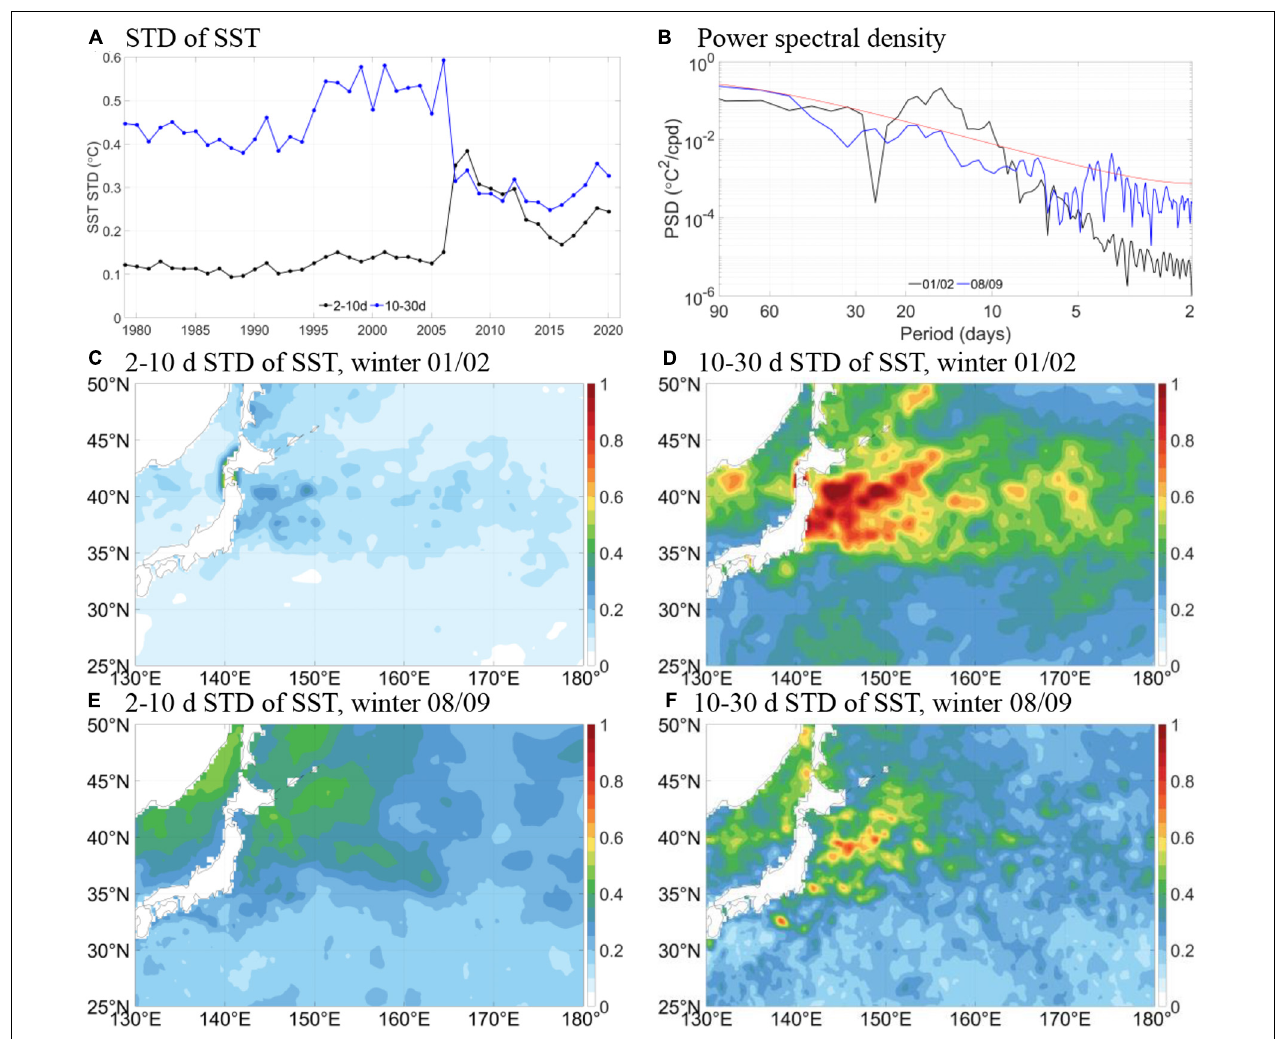
FIGURE 2 | (A) Multi-year series of standard deviation ( ◦ C) of 2–10 days and 10–30 days SST variability in winter (DJF) averaged over the KOE region (142–155 ◦ E, 35–45 ◦ N). (B) Power spectral density ( ◦ C 2 /cpd) of SST at 145 ◦ E, 38 ◦ N for winter 2001/02 and 2008/09. (C) Spatial distribution of standard deviation ( ◦ C) of 2–10 days SST variability in winter 2001/02. (D) Same as (C) but for 10–30 days SST variability. (E,F) Same as (C,D) but for winter